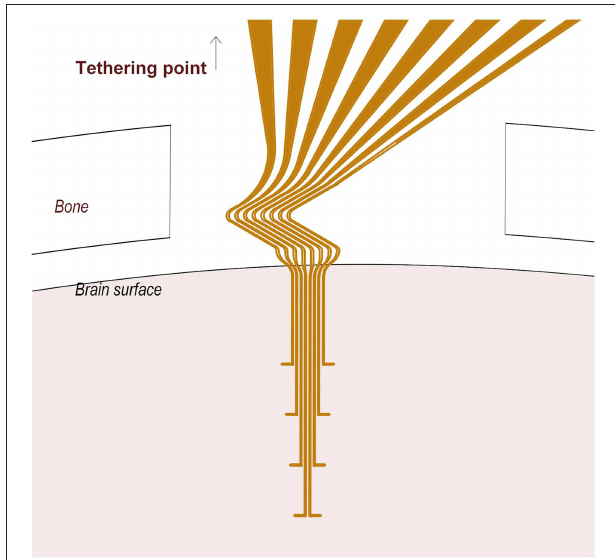
FIGURE 1 | A schematic of the 3D flexible electrode array. Note the Z-shaped proximal part of the electrode array located between the cranium and the brain surface, and the tips (10 µ m) of the distal protrusions which serve as recording